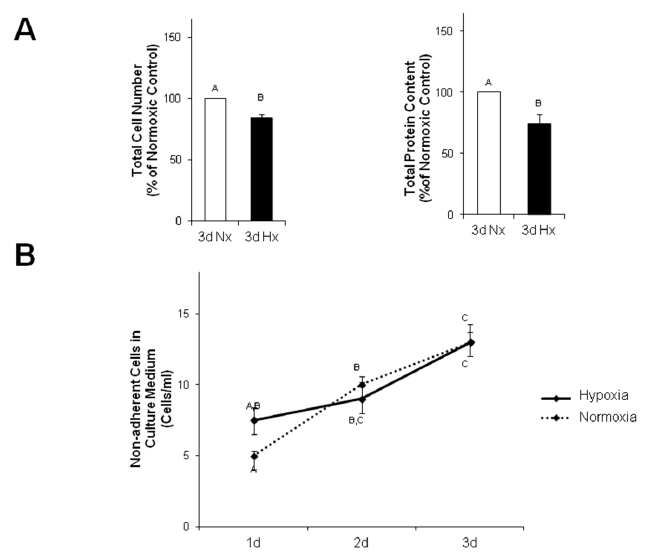
Figure 7. Reduced number of MVEC after 3 days of hypoxia. ( A ) After three days of normoxia or hypoxia total amount of MVECs ( n = 6) and total protein concentration per culture dish ( n = 7) were determined. ( B ) After one, two or three days of normoxia or hypoxia, the amount of non-adherent cells per mL culture medium was determined ( n = 5). Uppercase letters indicate significant differences between groups with p ≤ 0.05.